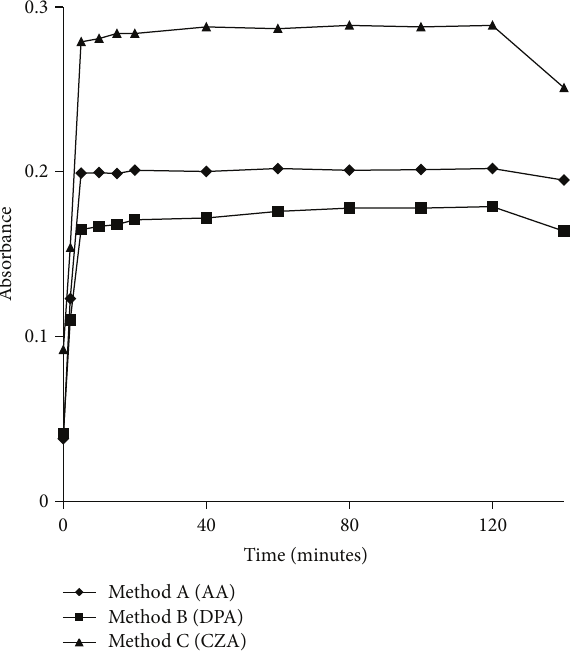
F 3: Effect of time and stability of the azo-dye.